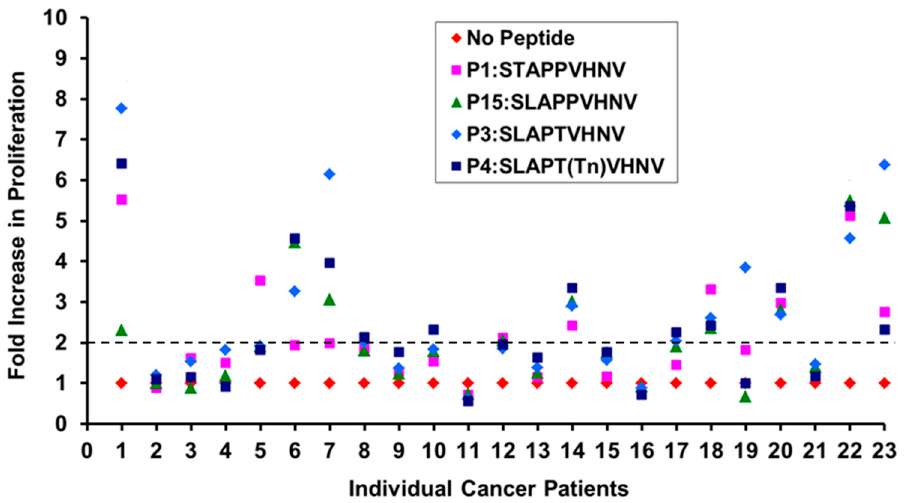
Figure 6. T cells from ~38% of the HLA-A2 + breast cancer patients regardless of their stage, ER/PR and HER2 status responded to the selected MUC1 peptides. 1 × 10 5 T cells were incubated with irradiated allogeneic DCs pulsed with the various MUC1 peptides (10 μ g/mL) + IL ‐ 2 for 5 days in complete media. Proliferation was assessed by measuring the 3 H ‐ thymidine uptake and is reported as fold increase in counts per minute. The dotted line indicates the two ‐ fold increase in proliferation.